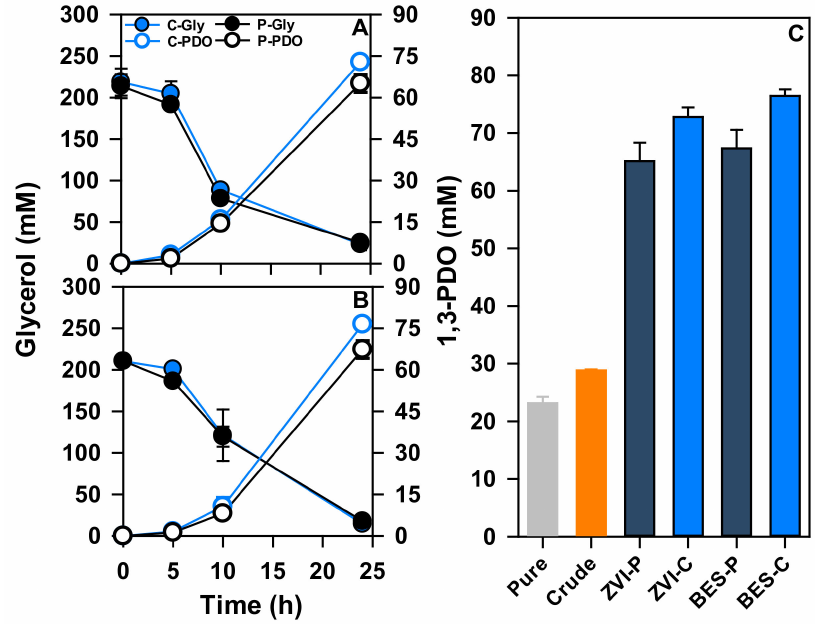
Figure 6. Crude and pure glycerol (200 mM) applied to BES and ZVI. Productivity of 1,3-PDO and glycerol consumption using ( A ) BES, ( B ) ZVI, and ( C ) 1,3-PDO production with and without ZVI and BES for crude and pure glycerol (P: pure glycerol; C: crude